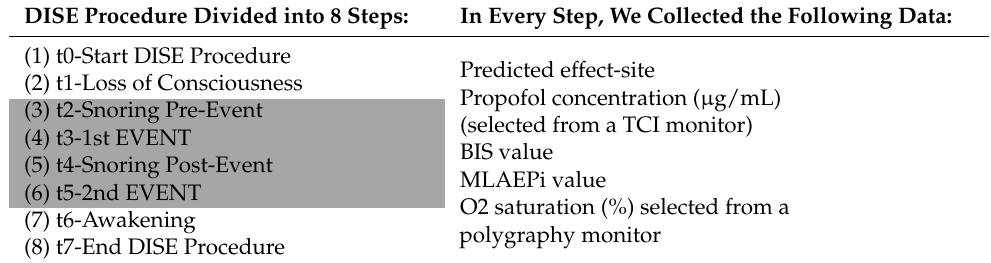
Table 2. Timing (t) and step definitions of data collection.